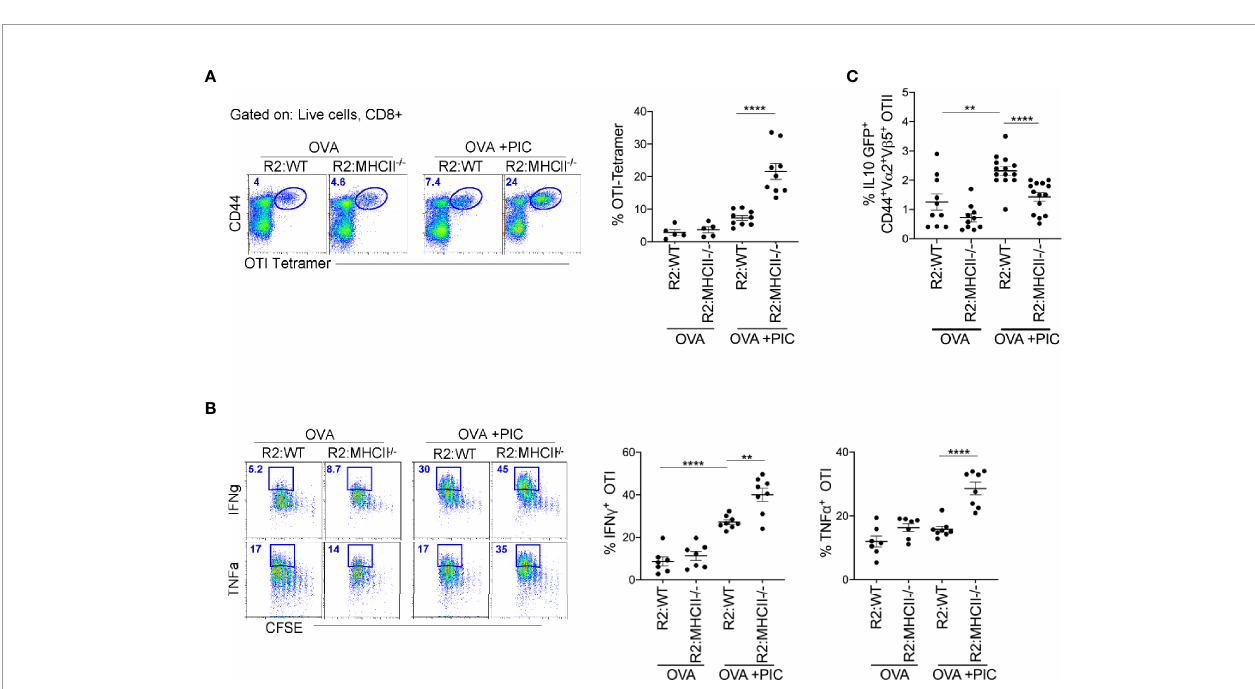
FIGURE 5 | Poly IC-induced IL-10 production to suppress antigen-speci fi c CTL response is done by MHCII + monocytes. (A) OTI SIINFEKL tetramer + T cells was examined in BM Chimeric mice after immunization and adoptive transfer (i.v.) of OTI cells. Scatter plot shows analysis of targeted population frequency from individual mice (right) and fl ow panel illustrate the representative CD44 + Tetramer + OTI cells (left). Combined set of 2 independent experiment, n=3-5 mice per group. (B) After immunization as outlined in Figure 1B , LLN antigen-speci fi c OTII IL-10 GFP + T cells was examined in BM Chimeric mice. Combined set of 3 independent experiments, n=3-5 mice per group . (C) Lethally irradiated mice were reconstituted 80:20 with CCR2 -/- and MHCII -/- BM cells: R2:MHCII chimeric mice. Control mice were reconstituted 80:20 with CCR2 -/- and WT BM cells: R2:WT chimeric mice. Flow and Scatter plot analysis of cytokine frequency from respective BM chimeric mice. Representative data of 2 independent experiments, n=3-5 mice per group. Data are shown as mean ± SEM. Each dot represents a mouse. ****P value < 0.0001. **P <